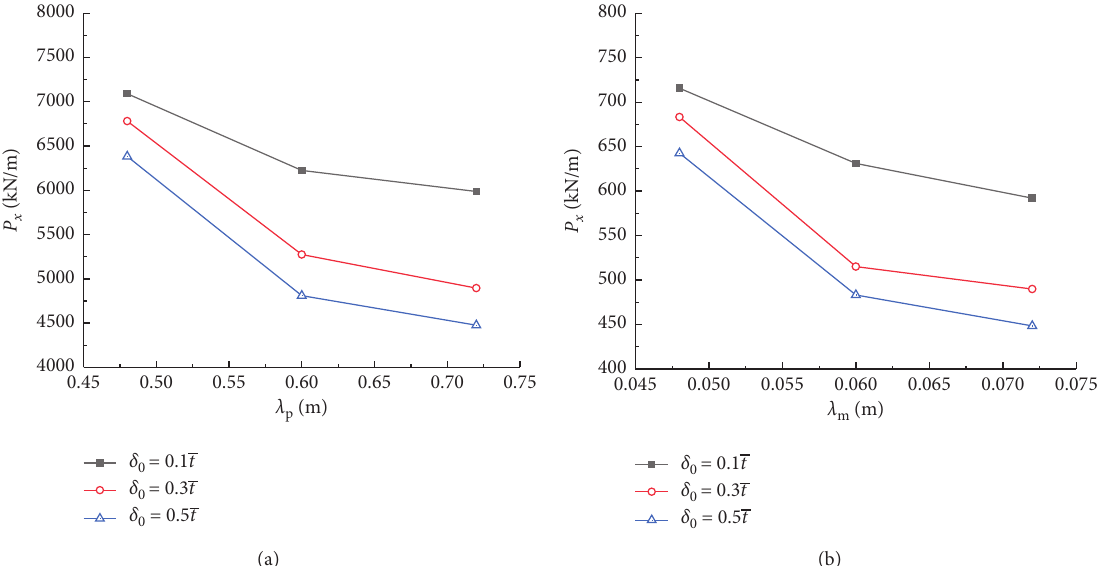
Figure 3: Imperfection sensitivity of the prototype and model under different imperfection diameters and amplitudes. (a) Prototype. (b)